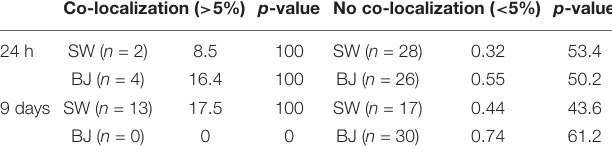
TABLE 2 | Borrelia burgdorferi did not co-localize with lysosomes—the number of human cells (n) with average percentages of co-localization between Borrelia and lysosomes, and Costes’ p -value, at 24 h and 9 days